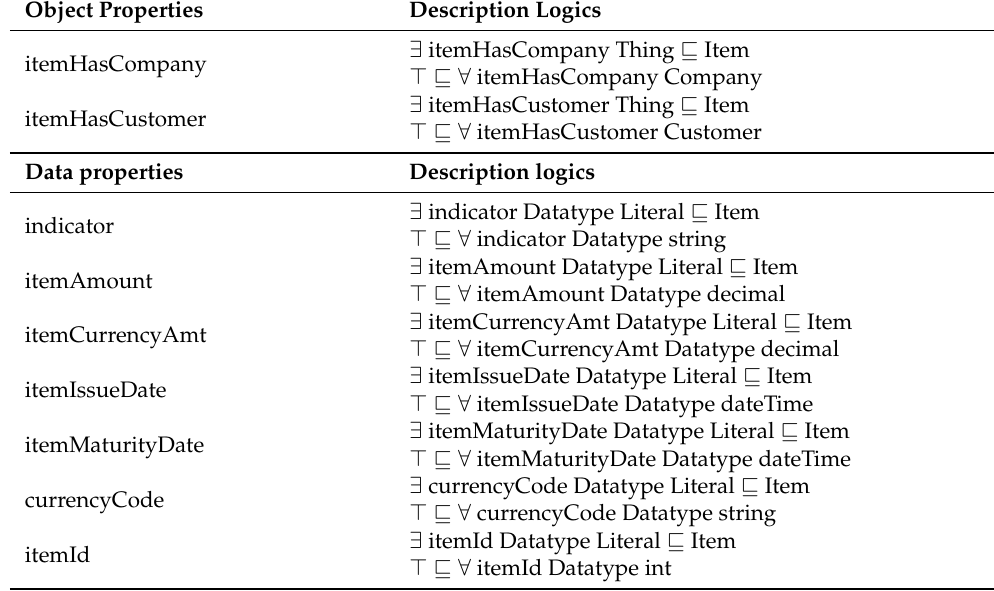
Table 4. Data and object properties of class Item.